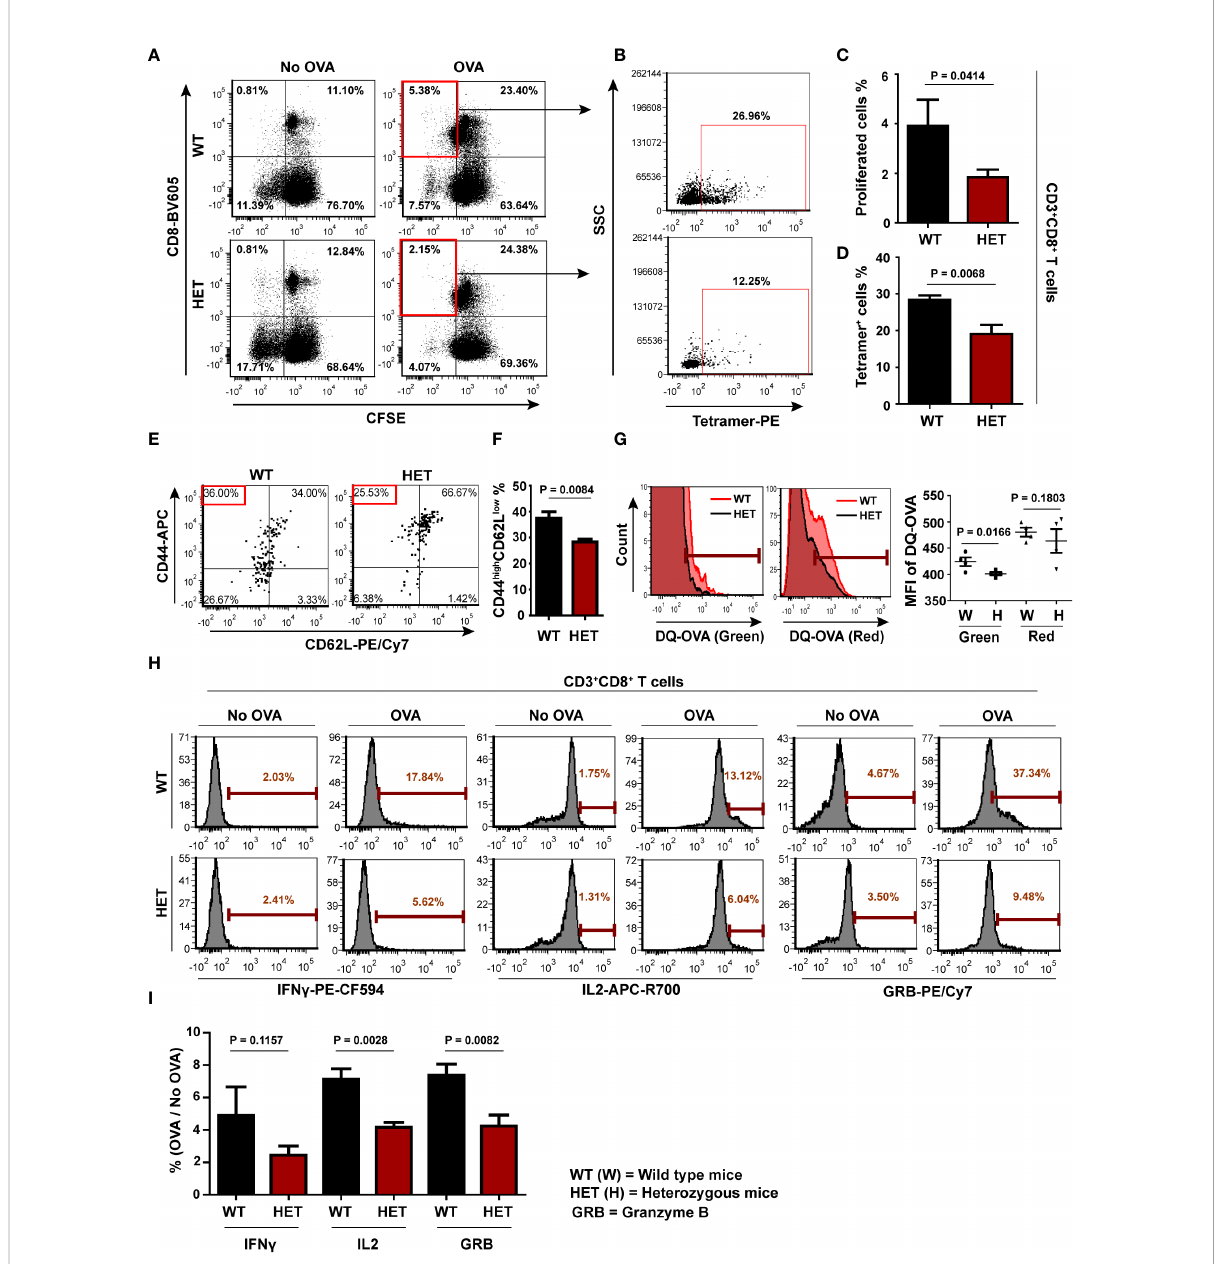
FIGURE 5 CD8 T cell recall response to OVA is impaired in Wnt5A heterozygous (Wnt5A +/-) mice: (A) : Signi fi cantly less CD8 T cell proliferative response in splenocyte cultures of OVA immunized Wnt5A heterozygous (HET) mice in response to added OVA in comparison to that of the corresponding wild-type cohorts (WT) is demonstrated by CFSE dye dilution through FACS. Less OVA responsive CD8 T cell proliferation in case of Wnt5A heterozygous mice correlates with a reduced percentage of SIINFEKL-MHCI tetramer binding CD8 T cells (B) . (C , D) : Graphical estimate of the percentage of OVA responsive proliferating CD8 T cells and SIINFEKL-MHCI tetramer binding cells in OVA immunized Wnt5A heterozygous and wild-type mice (for C , n=7 and for D n=4 n representing the number of mice in each group). Higher percentages of SIINFEKL MHCI-tetramer (PE) binding CD8 T cells in WT than in HET correlate with a relatively higher degree of effector phenotype [CD44high (APC) CD62Llow (PE-CY7)] in the WT (E, F) (n = 4). Quadrant setup was based on the secondary control of CD62L and unstained cells. (G) Representative FACS histogram and distribution plot show less DQ-OVA processing in splenic CD11c positive cells of Wnt5A heterozygous mice as compared to those of Wnt5A wild-type mice in both FITC and PE-Texas red channels (n = 4). (H , I) : Representative histograms of % OVA responsive CD8 T cells (compared to no-OVA stimulation) with high intracellular IL2 (APC-R700), IFN g (PE-CF594) and GRB (PE-Cyanine 7) levels as demonstrated by FACS of splenocytes of OVA immunized WT and HET mice (H) and the overall projection of stimulation index (%OVA/ %no-OVA) for the different cytokines (I) (n= 4). Marker gate (highly positive cells) of the OVA sets for each cytokine was based on the corresponding no OVA control. An unstained cell histogram of each cytokine was used as a reference. Data presented as mean ± SEM. The exact p values are depicted in the fi gure using the Student ’ s unpaired